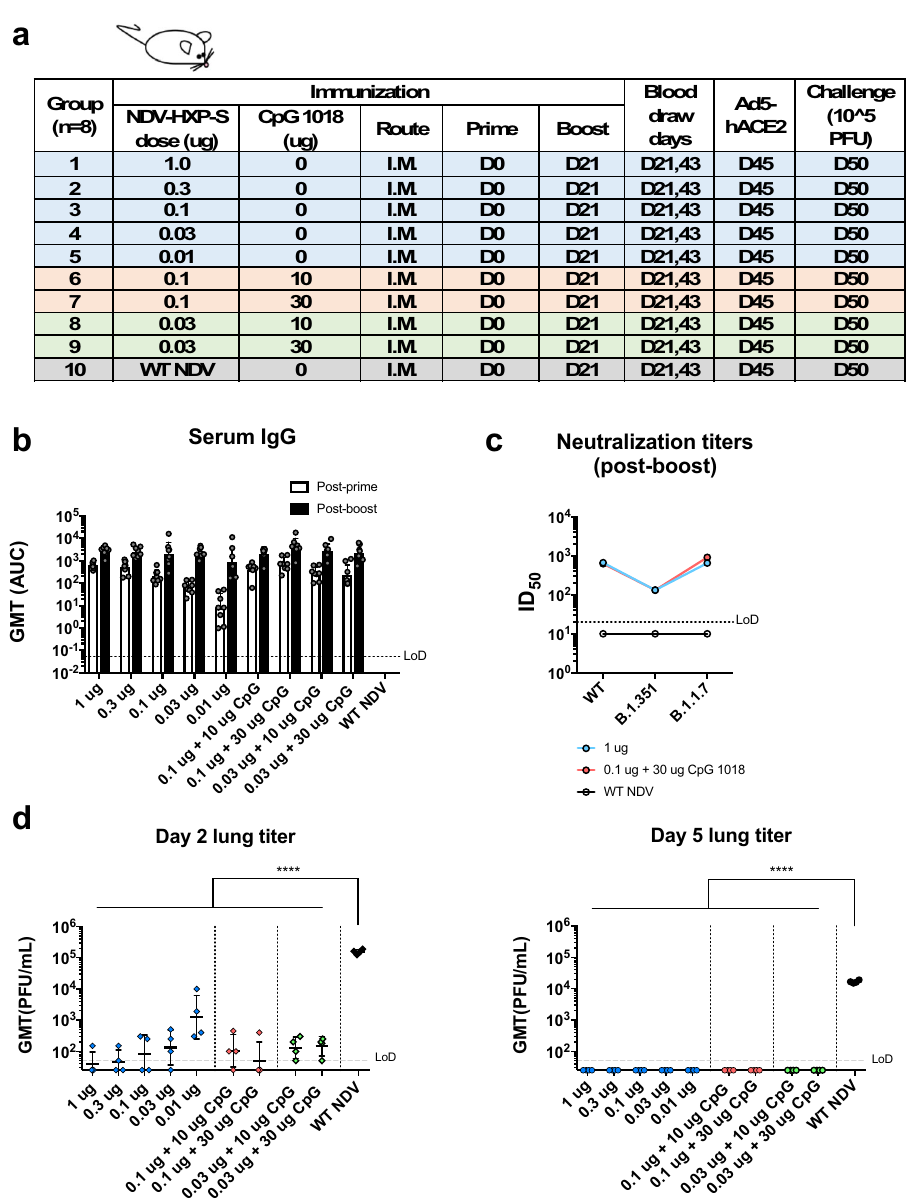
Fig. 2 Low doses of inactivated NDV-HXP-S induce a protective antibody response in mice. a Design of the study. Nine-to-ten-week-old female BALB/c mice were used. Group 1 – 5 ( n = 8) were vaccinated with unadjuvanted NDV-HXP-S at 1 µ g, 0.3 µ g, 0.1 µ g, 0.03 µ g, and 0.01 µ g per mouse, respectively. Group 6 and 7 ( n = 8) were vaccinated with 0.1 µ g of NDV-HXP-S with 10 or 30 µ g of CpG 1018 per mouse, respectively. Group 8 and 9 ( n = 8) were vaccinated with 0.03 µ g of NDV-HXP-S with 10 or 30 µ g of CpG 1018 per mouse, respectively. Group 10 ( n = 8) was vaccinated with 1 µ g of WT NDV as the negative control. The vaccine was administered via the intramuscular (I.M.) route at D0 and D21. Blood was collected at D21 and D43. Mice were sensitized with Ad5-hACE2 at D45 and challenged with 10 5 PFU of the USA-WA1/2020 strain. b Spike-speci fi c serum IgG. Antibodies in post-prime (D21) and post-boost (D43) sera were measured by ELISAs. Geometric mean titer (GMT) represented by the area under the curve (AUC) was graphed, with geometric standard deviation (SD) as error bars. c Neutralizing activity of serum antibodies. Post-boost sera from group 1, group 7, and group 10 were pooled within each group and tested in neutralization assays against the USA-WA1/2020 strain (WT), the B.1.351 variant, and B.1.1.7 variant in technical duplicate. Serum dilutions inhibiting 50% of the infection (ID 50 ) were plotted. (LoD: limit of detection; LoD = 1:20; An ID 50 = 1:10 was assigned to negative samples). d Viral load in the lungs. Lungs of a subset of animals ( n = 4) from each group were collected on day 2 and day 5 post challenge. The whole lungs were homogenized in 1 mL of PBS. Viral titers were measured by plaque assay on Vero E6 cells and plotted as GMT of PFU/mL (LoD = 50 PFU/mL; a titer of 25 PFU/mL was assigned to negative samples). The error bars represent geometric SD. Statistical difference was analyzed by ordinary one-way ANOVA corrected for Dunnett ’ s multiple comparisons test (**** p < 0.0001). (blue: unadjuvanted groups; red: 0.1 µ g adjuvanted with CpG 1018; green: 0.03 µ g adjuvanted with CpG